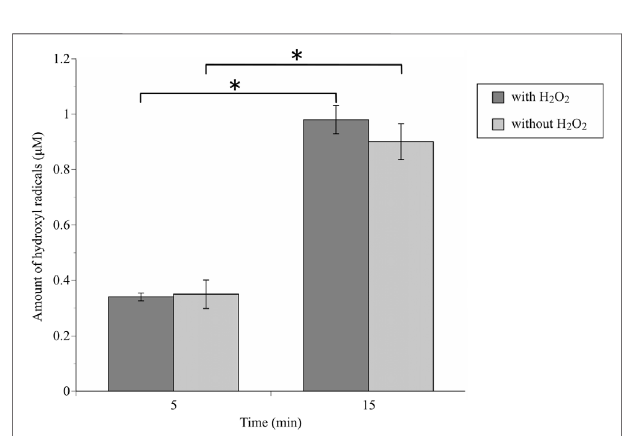
(cid:129) OH radicals